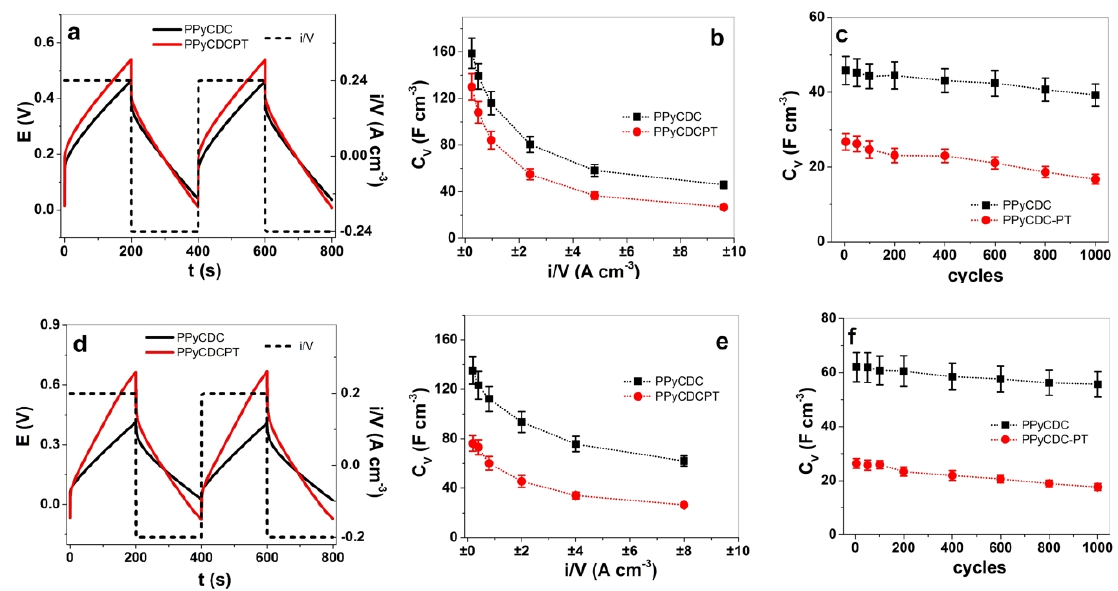
Figure 6. Chronpotentiometric measurements of PPyCDC (black line, ■ ) and PPyCDC-PT (red line, ● ) with the variation in the frequency and current density using LiTFSI salt, with results showing the aqueous solvent potential time curve (3rd–4th cycle) with the current density (dashed line, ±0.24 A cm − 3 ), presented in ( a ), the volumetric capacitance C V against the applied current densities (from ±0.24 A cm − 3 to ±9.6 A cm − 3 ), presented in ( b ), and the long-term measurements of 1000 cycles (0.1Hz, ±9.6 A cm − 3 ), displayed in ( c ). The PPyCDC and PPyCDC-PT formed in the aqueous electrolyte, showing the potential time curve (±0.2 A cm − 3 ) in ( d ), the volumetric capacitance against the applied current density in ( e ), and the long-term measurements at ±8 A cm − 1 (1000 cycle, 0.1 Hz) in ( f ).